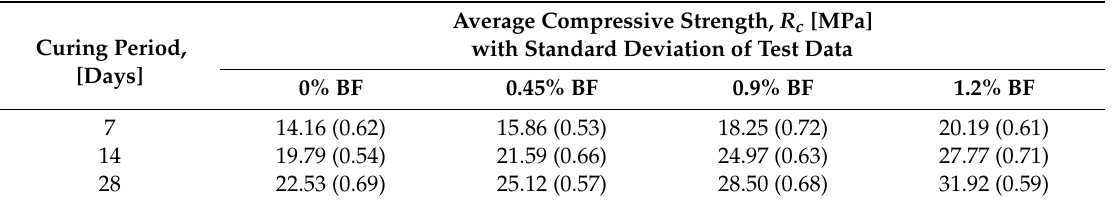
Table 5. Results of laboratory tests of control ECC specimens on compressive